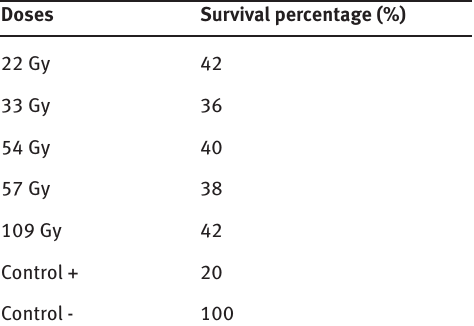
Table 1: Survival percentage of irradiated plants after the R.solani